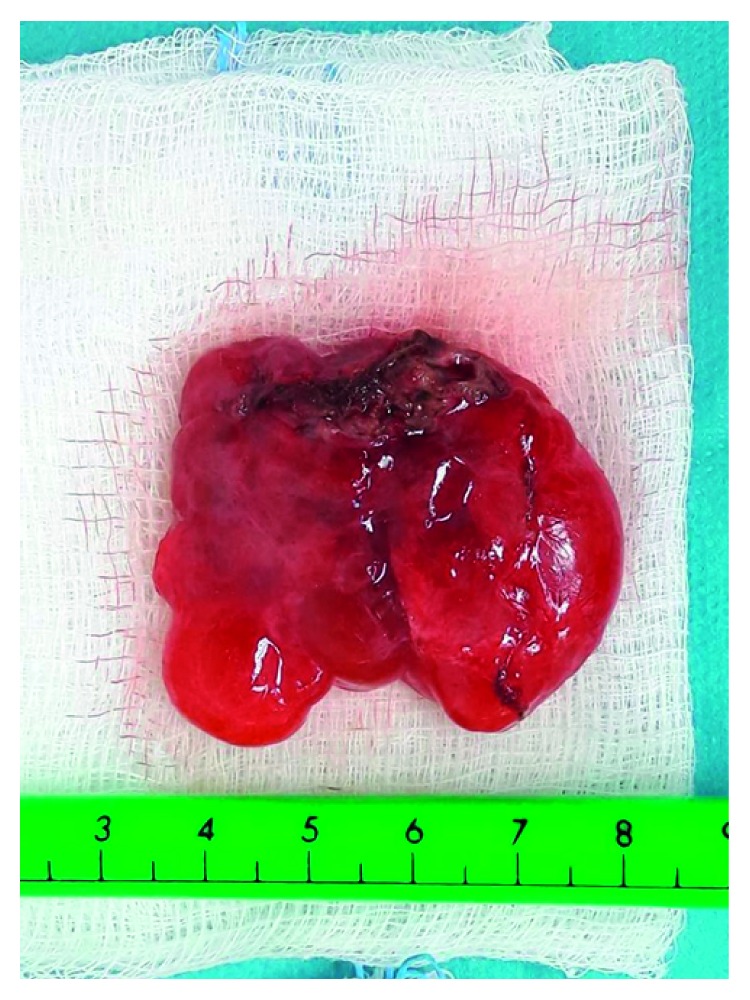
The abdominal LMA.